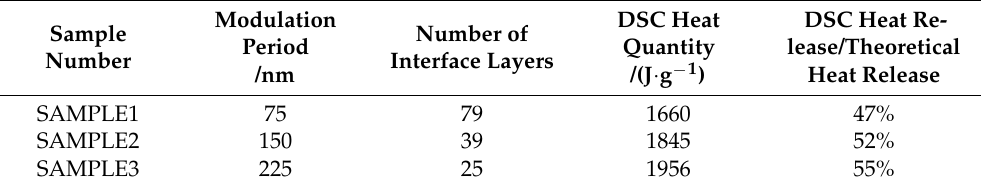
Figure 2. DSC curves of nano Al/CuO energetic composite films with different modulation periods. Table 1. Comparison of heat release of nano Al /CuO energetic composite films with different modulation